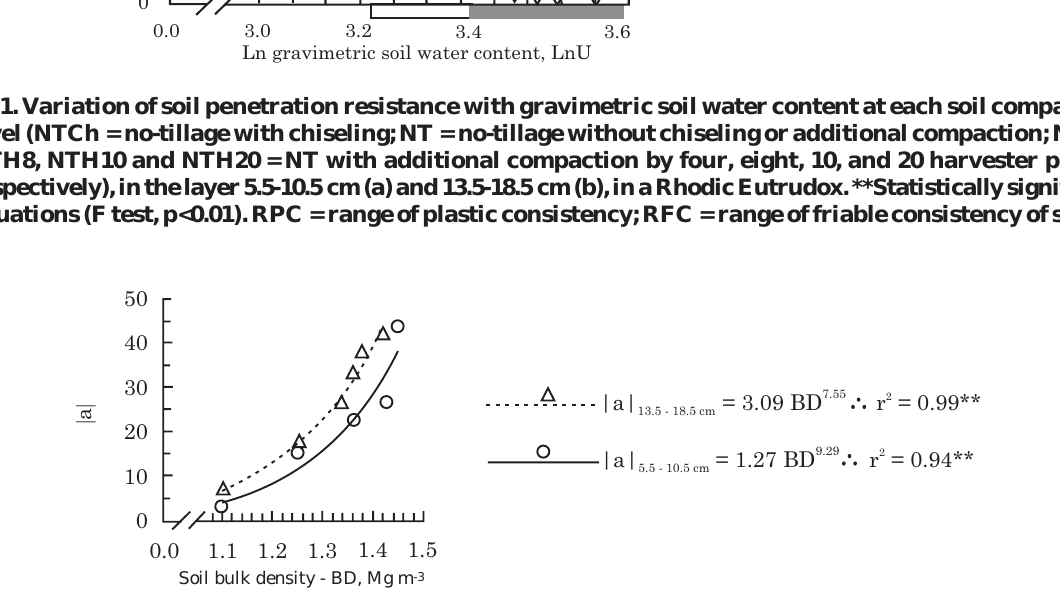
Figure 2. Variation of |a| with the soil bulk density assessed in the field in the 5.5-10.5 and 13.5-18.5 cm layer, in a Rhodic Eutrudox. **Statistically significant equations (F test,